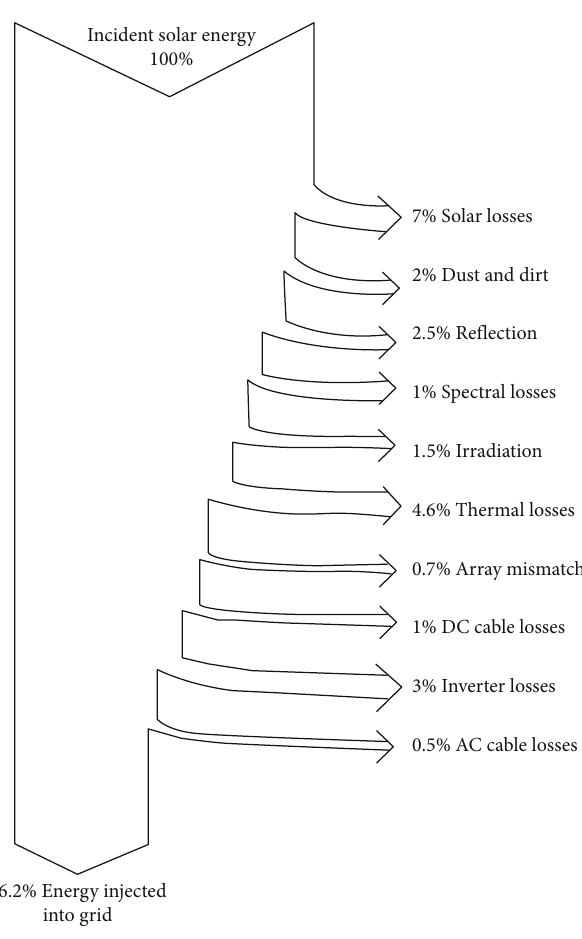
Figure 6: Sankey diagram for photovoltaic system losses